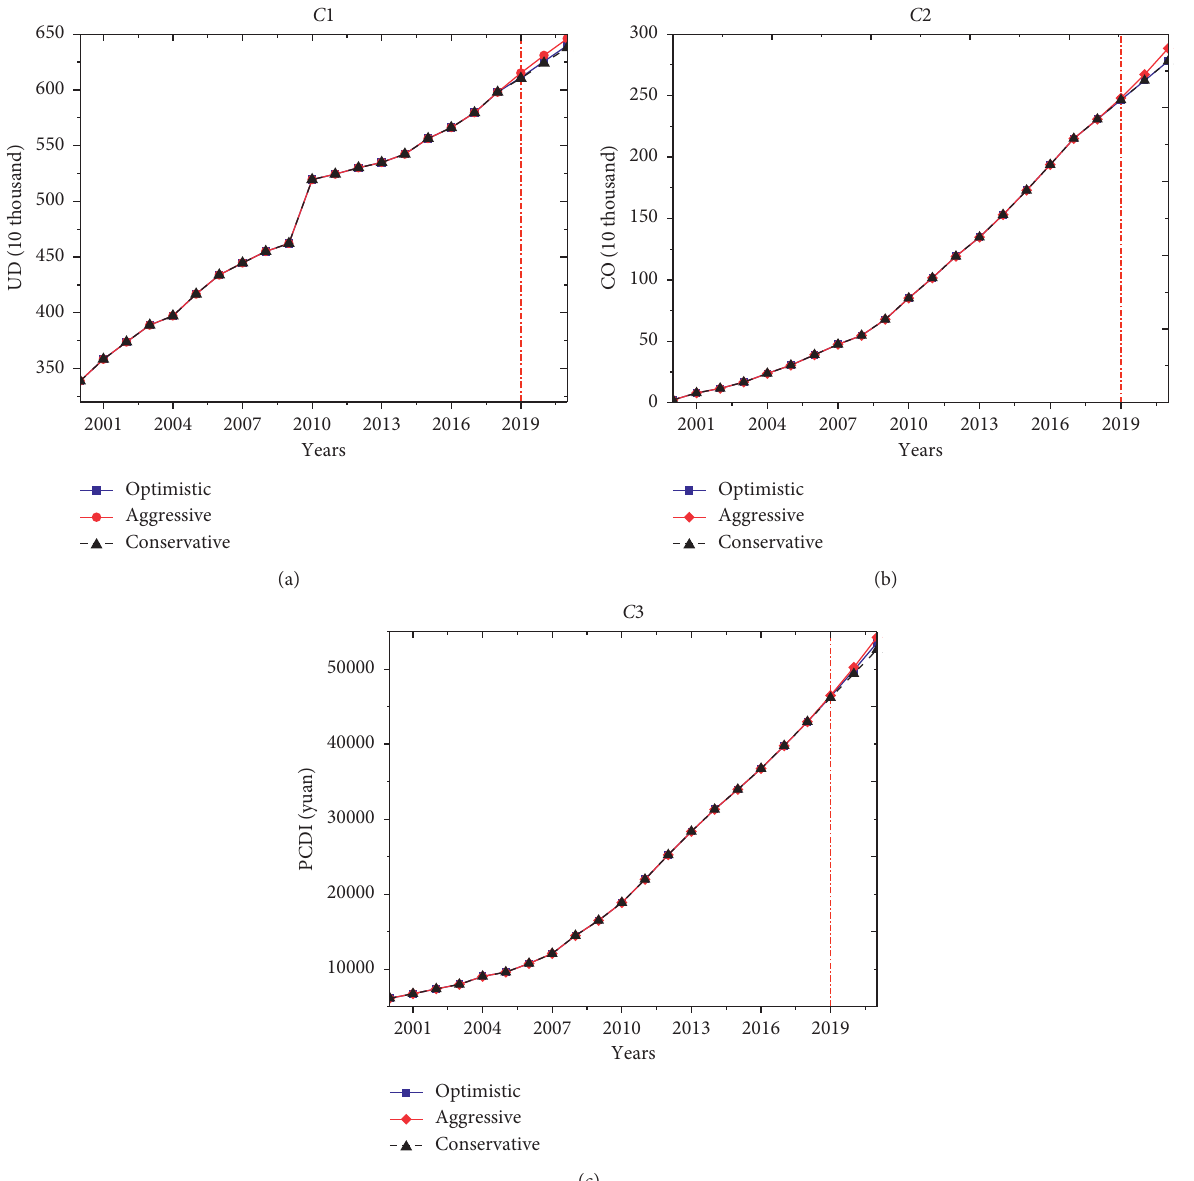
Figure 9: Future changes in the three data series for Kunming (2019–2021): (a) future changes in UD, (b) future changes in CO, and (c) future changes in